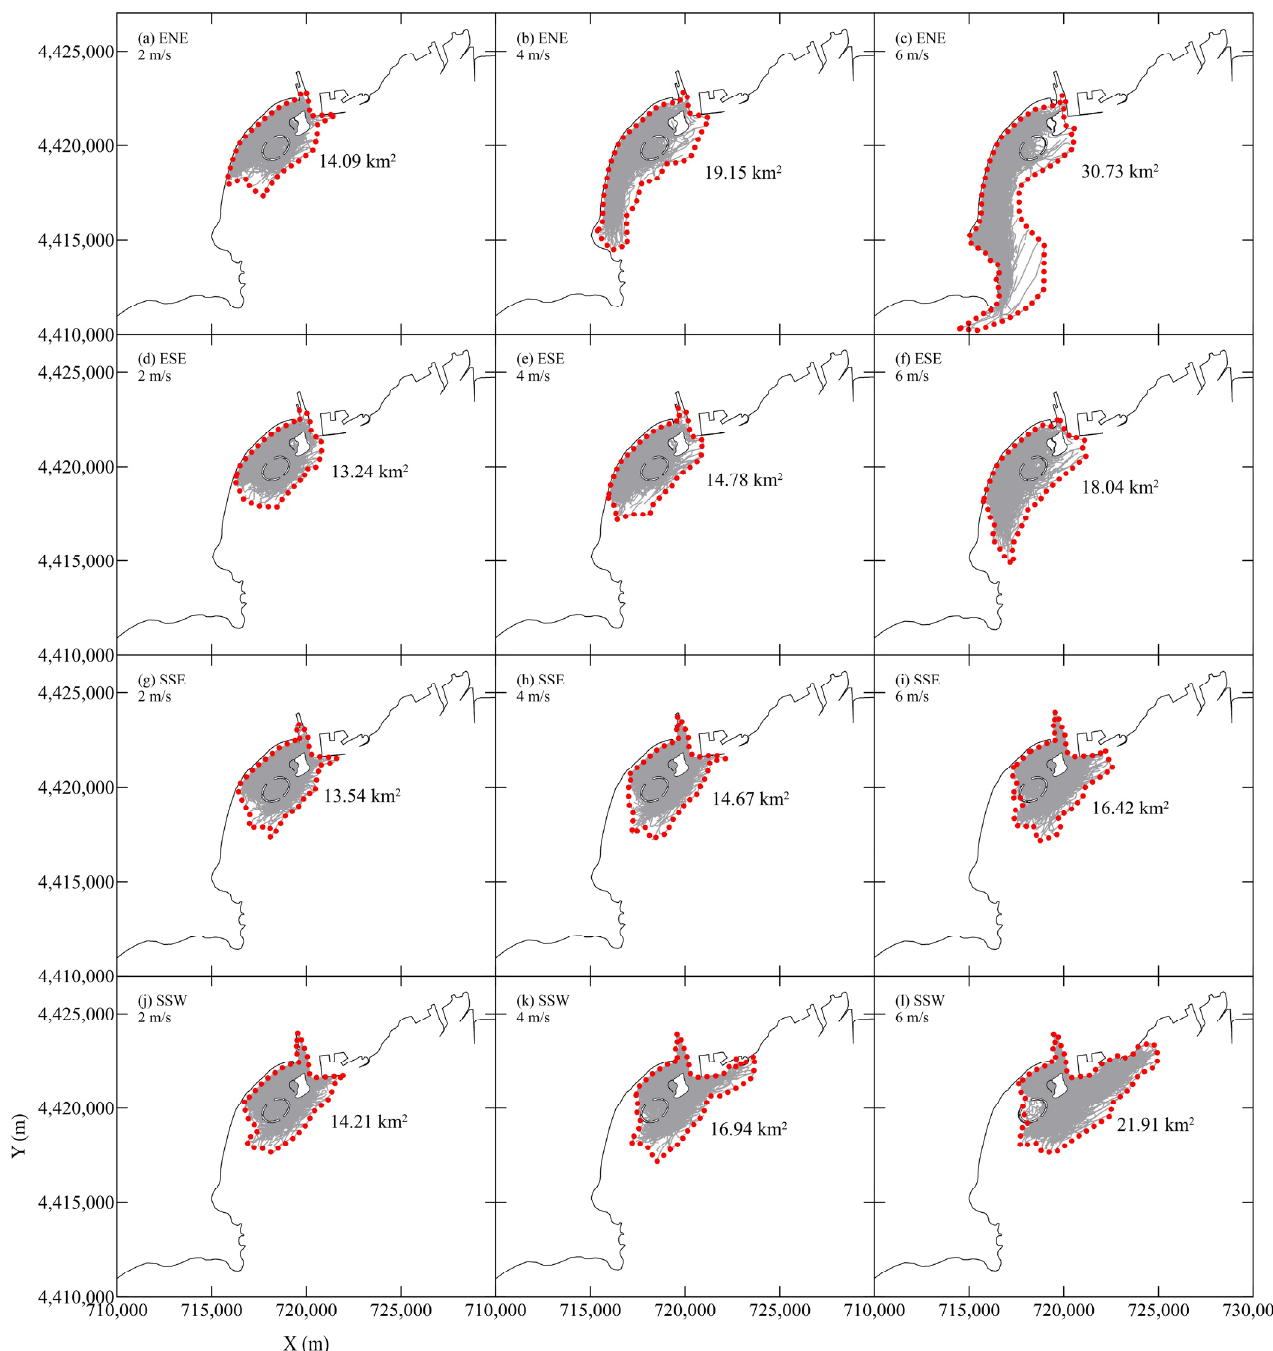
Figure 11. Trajectories of green macroalgae under the wind magnitudes of ( a , d , g , j ) 2 m/s, ( b , e , h , k ) 4 m/s, and ( c , f , i , l ) 6 m/s with the wind directions of ENE, ESE, SSE, and SSW, respectively. The areas surrounded by dotted red lines represent the coverage of the green macroalgae trajectories.